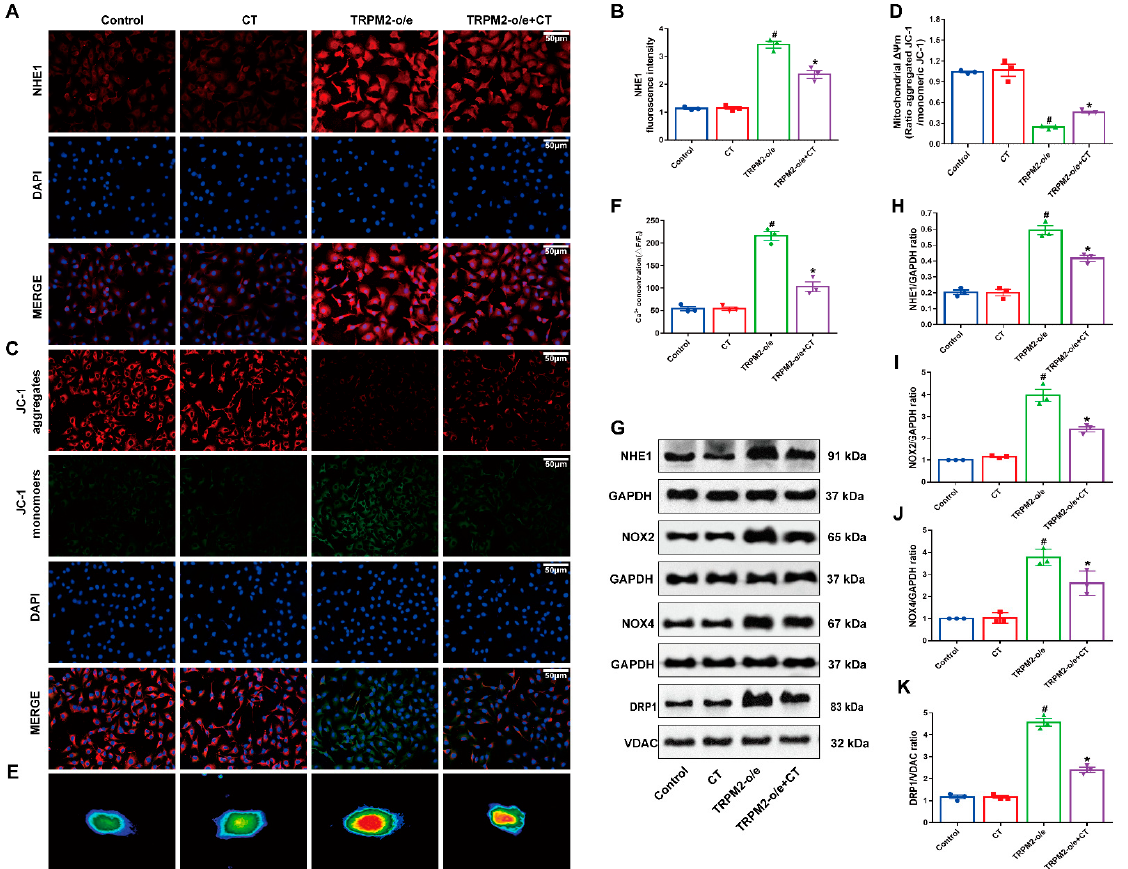
Figure 5. CT suppressed the expression of NHE1 protein and oxidative stress-induced mitochondrial damage in endothelial cells with overexpression of TRPM2. ( A ) The immunofluorescence detection of NHE1 in endothelial cells (NHE1, red ). ( B ) Quantitative analysis of fluorescence intensity of NHE1. ( C ) Detection of mitochondrial membrane potential in endothelial cells (JC-1aggregates, red ; JC-1 monomers, green ). ( D ) The quantitative analysis of the mitochondrial membrane potential ( Δψ m). ( E ) Calcium concentration in endothelial cells was detected by calcium imaging technology. ( F ) Quantitative analysis of calcium fluorescence intensity in endothelial cells. ( G – K ) Western blot analysis of NHE1, NOX2, NOX4, and DRP1 in endothelial cells (N = 3). Data were analyzed by one-way ANOVA by Tukey post hoc tests or Bonferroni post hoc analyses. All data were expressed as mean ± SEM. # p < 0.05 vs. Control group, * p < 0.05 vs. TRPM2-o/e group.